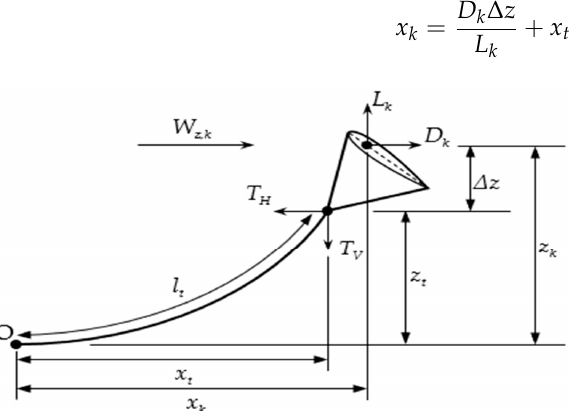
Figure 1. A two-dimensional representation of the kite system configuration and external forces for the ideal case that the wind and ship direction are the same for a forward relative wind speed, W z , k